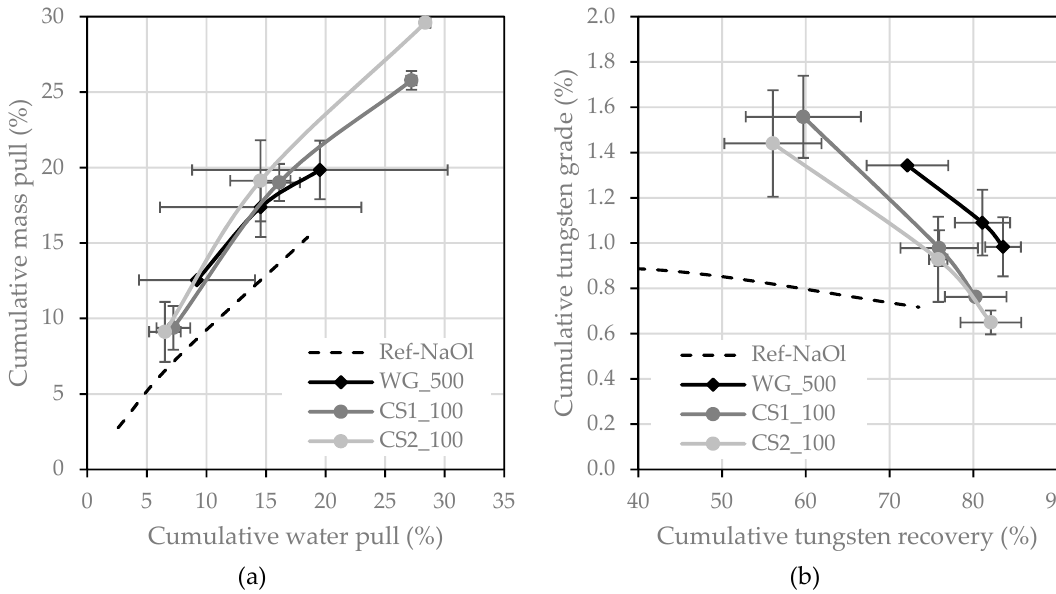
Figure 3. ( a ) Mass pull against water pull and ( b ) cumulative tungsten grade against recovery (error bars represent the 95% confidence interval).